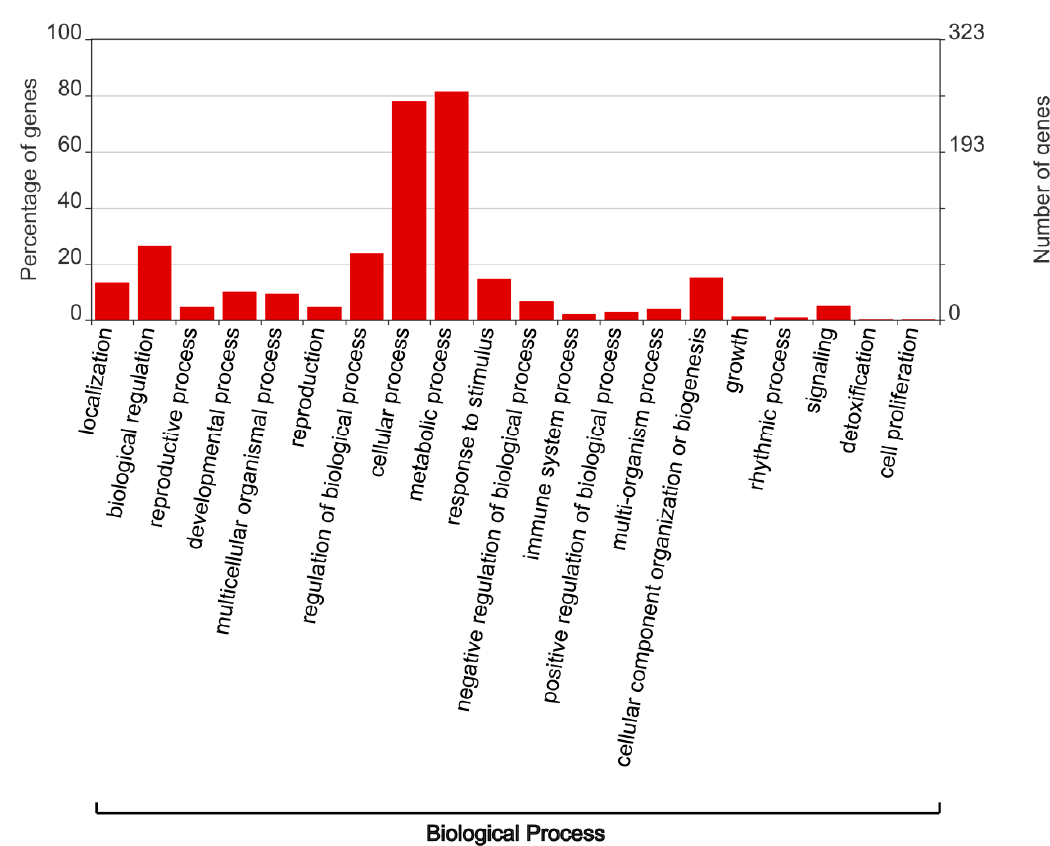
Figure 9. Go enrichment of genes related to LSM7 in the co-expression network. The figure illustrates the biological process enrichment of LSM7-related genes.